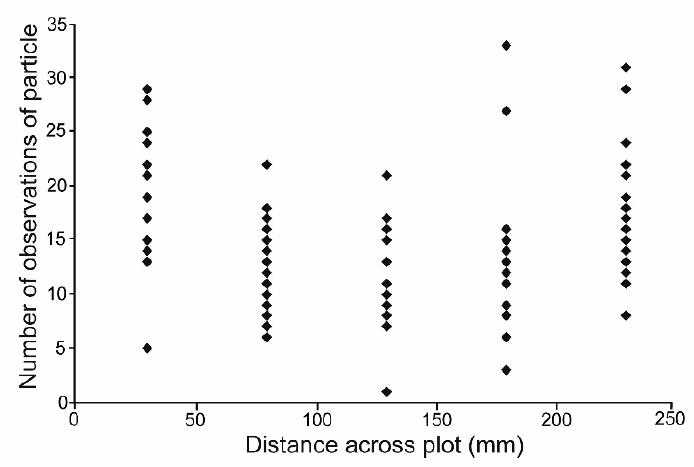
Figure 8. Plot of number of detections of individual particles against their location across the shallow depression in which they were sited.